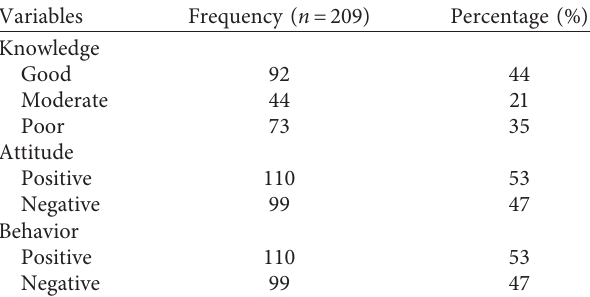
Table 2: Frequency of knowledge, attitude, and